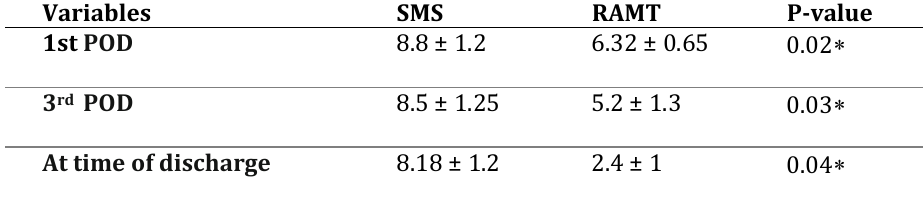
Table 3: Post-operative pain